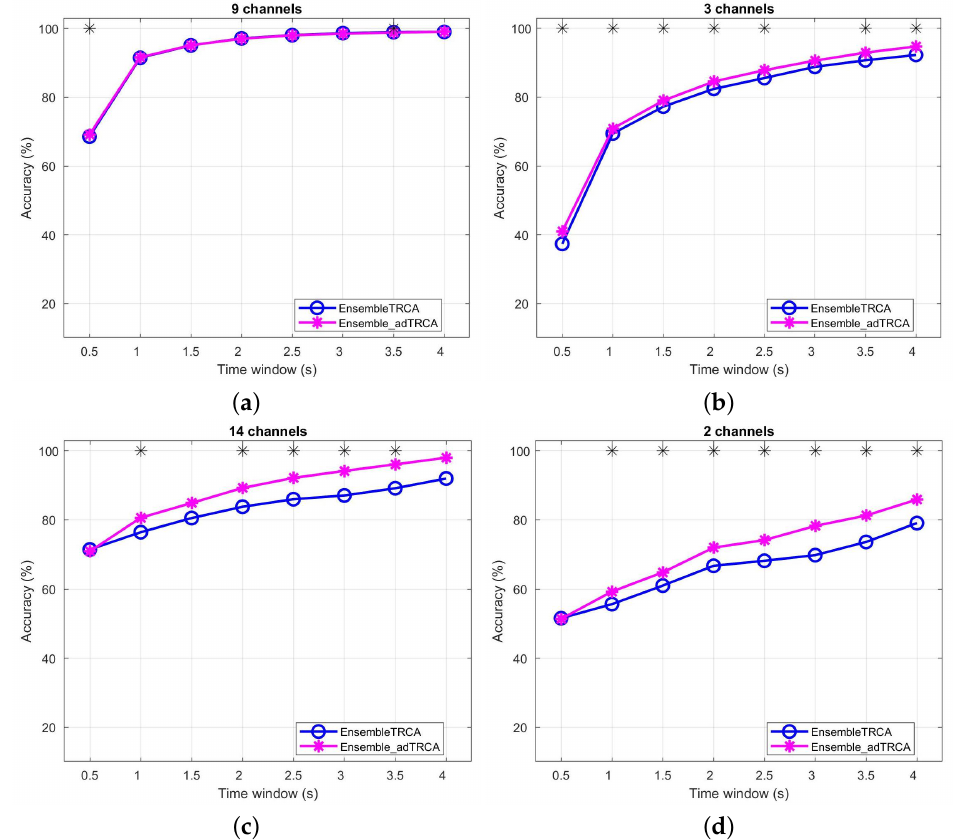
Figure 3. Average Classification over all subjects by using for the Speller dataset with ( a ) 9 channels and ( b ) 3 channels and for the EPOC dataset with ( c ) 14 channels and ( d ) 2 channels, respectively. In both cases, the time window ranges from 0.5 s to 4 s (0.5 s interval). * indicates statistically significant difference between the two methods using paired sample t -test for the Speller dataset and Wilcoxon signed rank test for the EPOC dataset ( p <